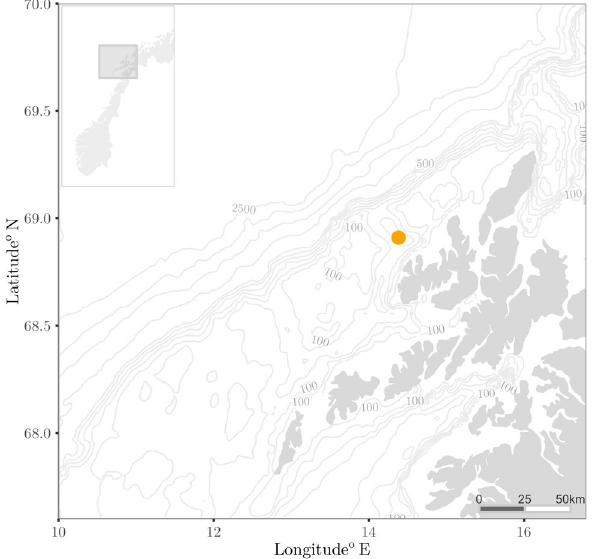
Figure 1. Map of the study area. The orange dot indicates the location of Node 1 of the LoVe Ocean Observatory. The figure was produced using the ggplot2 93 and marmap 94 R 87